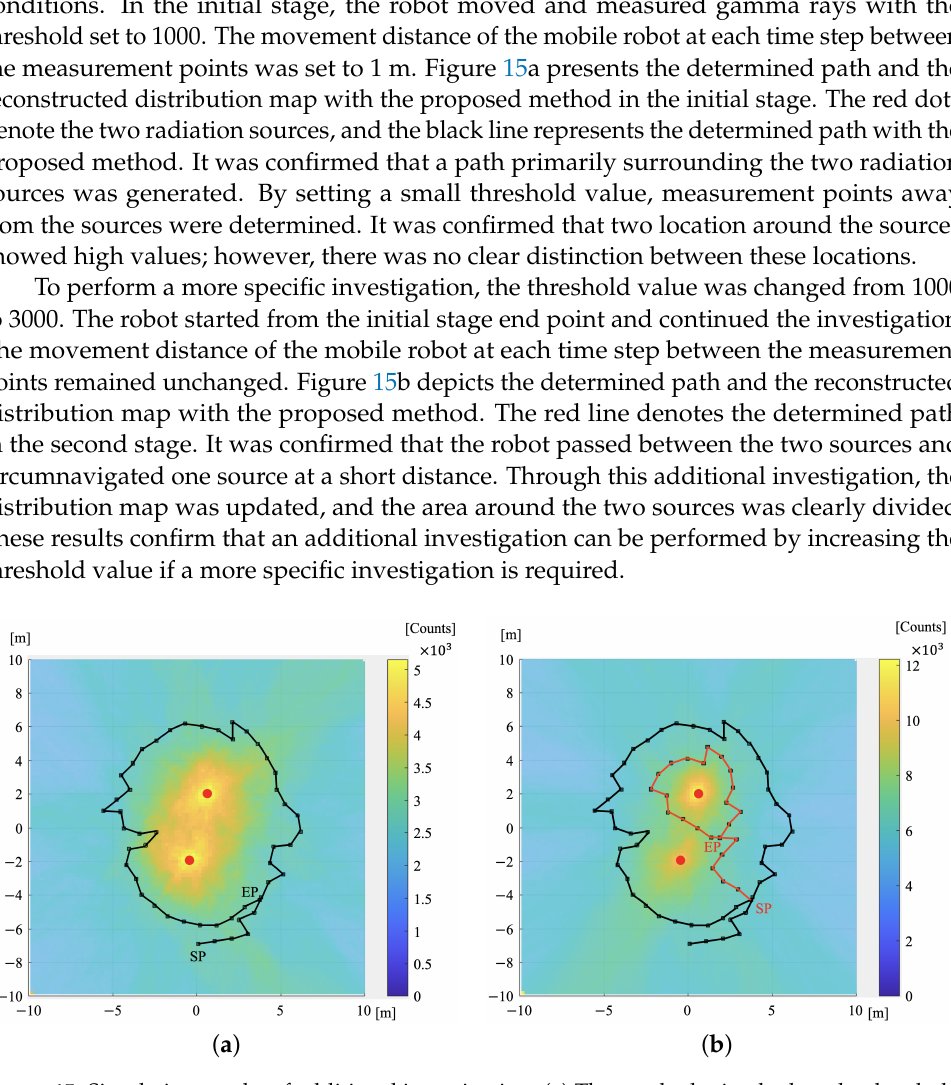
Figure 15. Simulation results of additional investigation: ( a ) The result obtained when the threshold was set to 1000 ( b ) The result obtained when the threshold was set as 3000. The black line depicts the determined path when the threshold was set to 1000, and the red line is the path with the threshold set to 3000. It was confirmed that the area around the sources was clearly divided through the additional